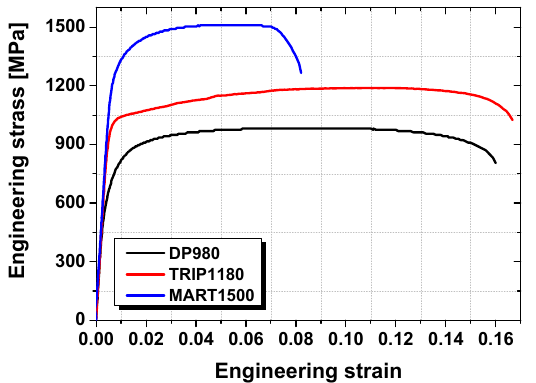
Figure 1. Engineering stress–strain curve of DP980, TRIP1180, and MART1500. Table 1. Material properties of DP980, TRIP1180, and MART1500. Material Property